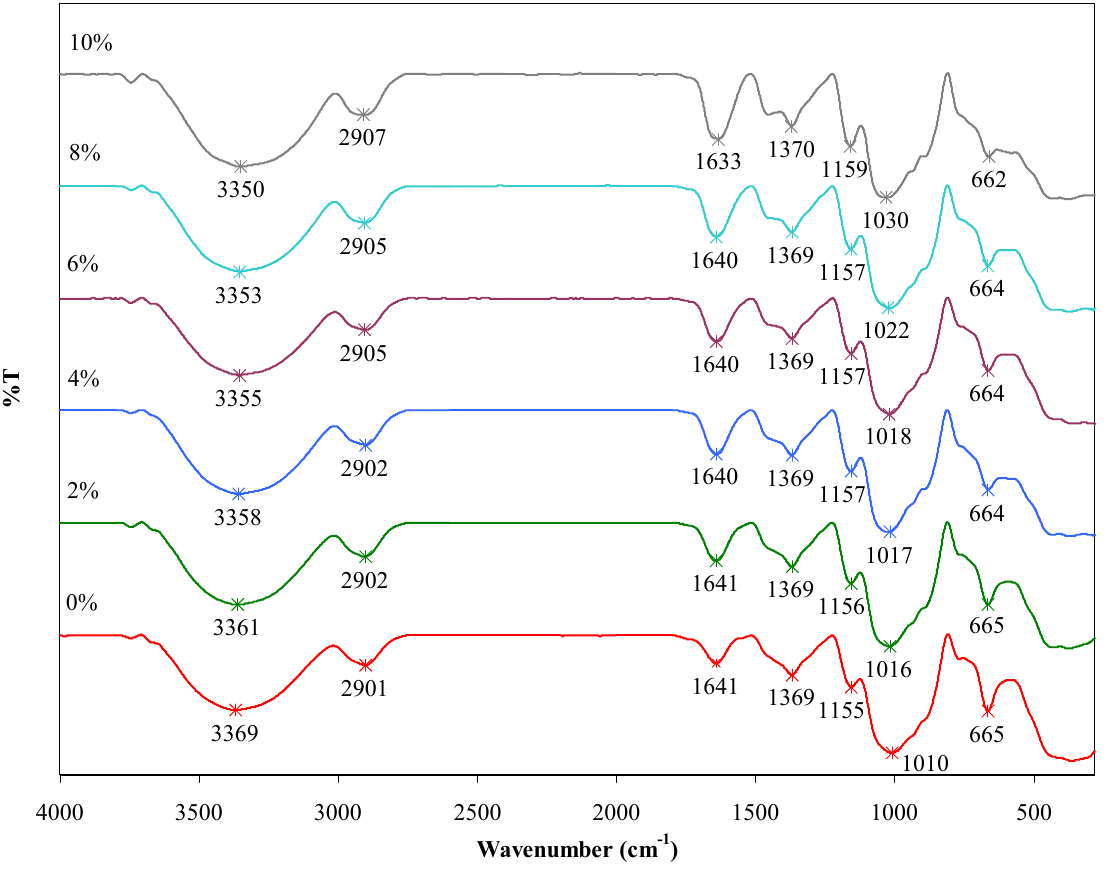
Figure 6. Fourier transform infrared spectroscopy (FTIR) spectra of the agarose/talc composite films with various contents of BmimCl/Urea.